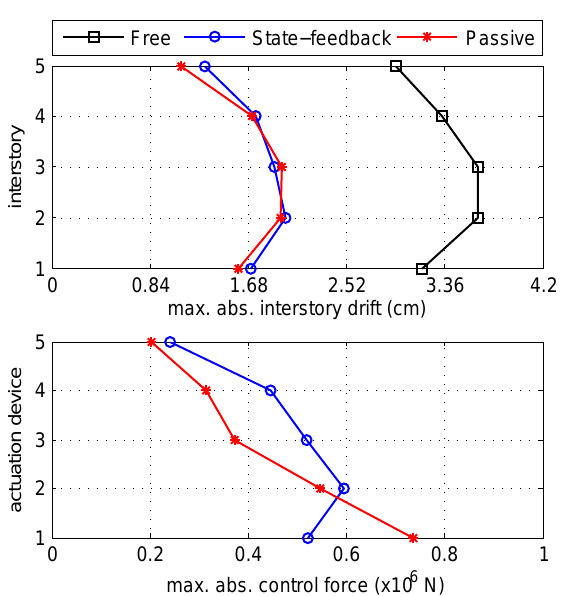
Figure 10: Maximum absolute interstory drifts and control